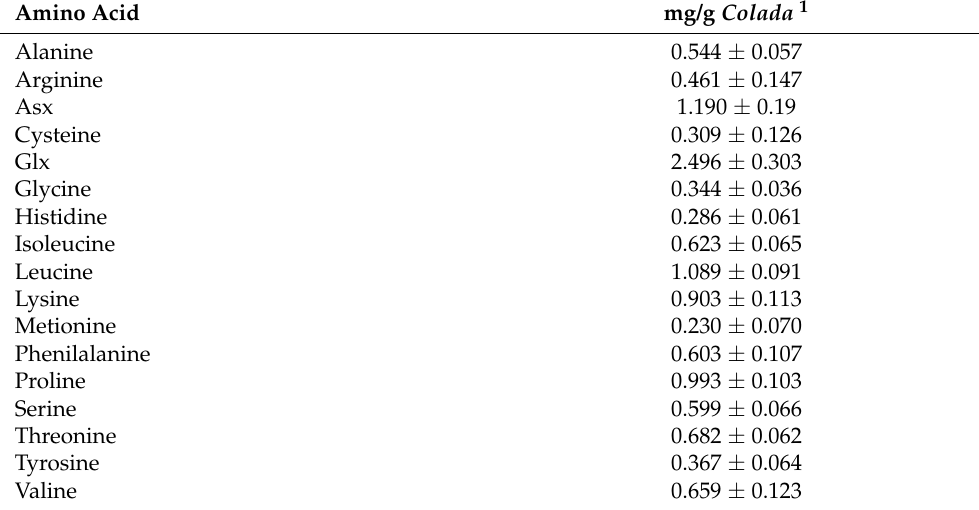
Table 2. Amino acid composition of the whey-beverage ( Colada